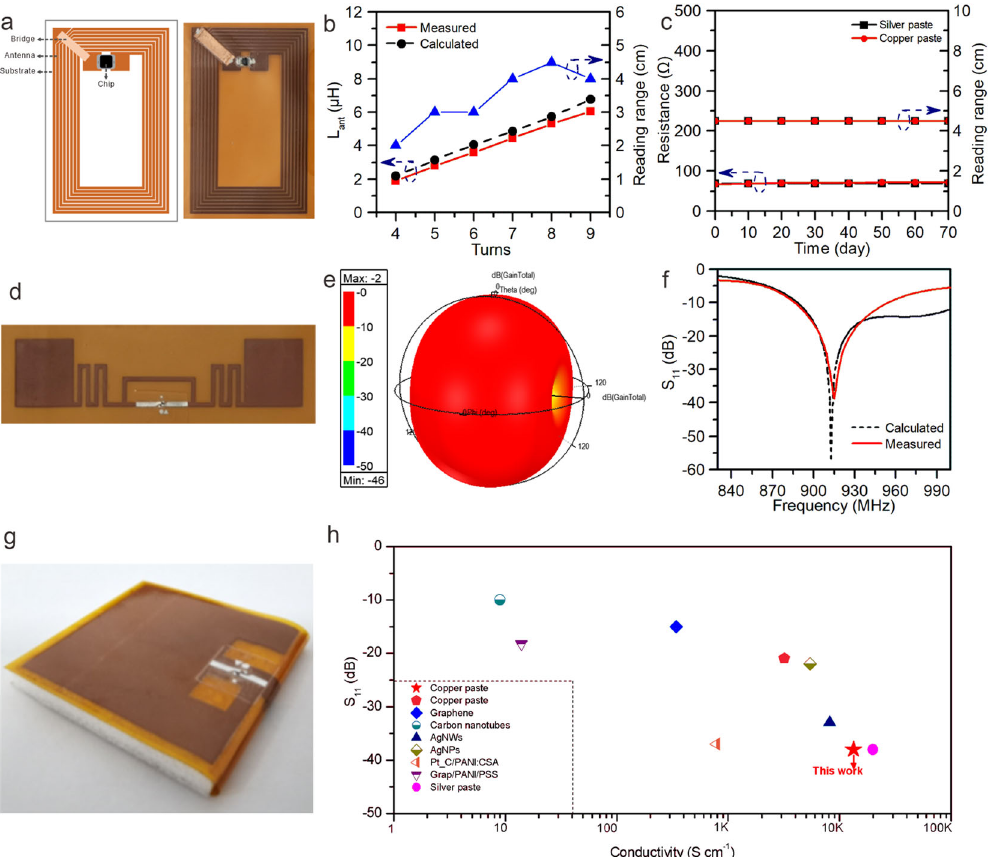
Fig. 6 Characterization of RFID tags. a Structure diagram (left) and physical picture (right) of HF RFID tag. b Calculated and measured inductance and reading range of HF RFID tag antennae affected by number of coils. c Comparative test on the long-term resistance and reading range of antennae with 8 coils fabricated by antioxidant copper paste and commercial silver paste. d Physical picture of the UHF dipole RFID tag. e Three-dimensional radiation pattern of the UHF dipole RFID tag antenna model calculated by HFSS. f Calculated and measured S 11 results of the fabricated UHF dipole tag antennae. g Physical picture of the UHF microstrip patch RFID tag. h Comparison of S 11 values and conductivity of antennae for different studied material with antioxidant copper